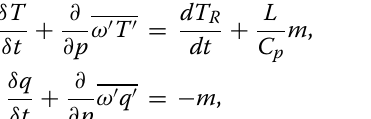
total heat supply from the sea to the atmosphere was estimated at about 580 W/m 2